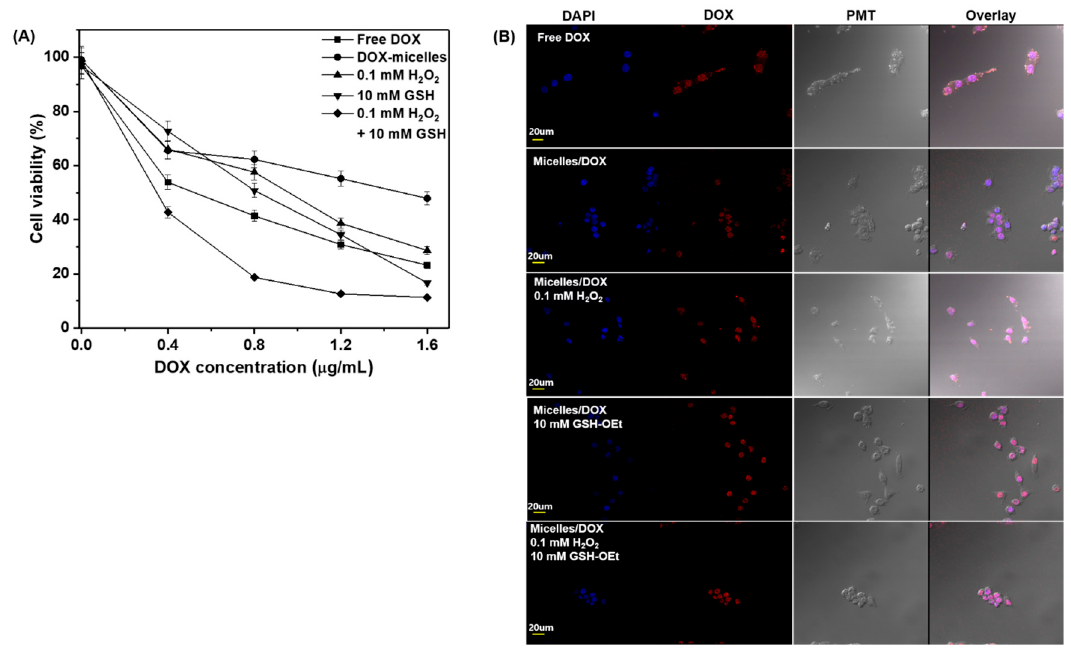
Figure 6. KB cell viability without and with pretreatment with GSH-OEt or H 2 O 2 followed by incubation with different amounts of DOX and DOX-loaded gemini mPEG-Cys-PMT micelles for 24 h, as determined using a CCK-8 assay (data are presented as mean ± SD of three independent experiments) ( A ) and confocal laser-scanning microscopy (CLSM) images of KB cells without and with pretreatment GSH-OEt or H 2 O 2 , and then incubated with DOX and DOX-loaded gemini mPEG-Cys-PMT micelles for 3 h. From left to right: DAPI staining, DOX fluorescence in cells, photomultiplier (PMT) images ( B ).